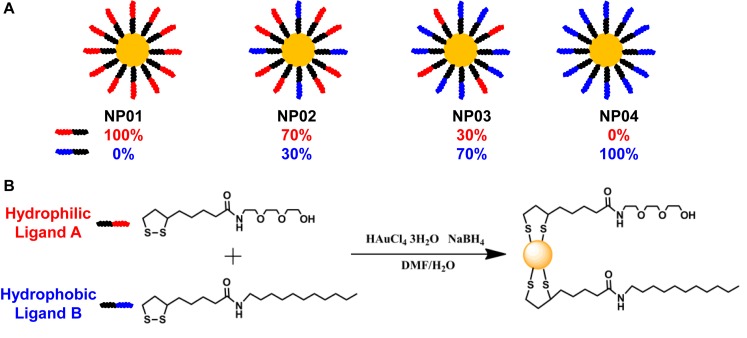
(A) Four nanoparticles (NP01∼NP04) were synthesized with continuous change in hydrophobicity. (B) Ligand chemical structures and the synthesis route.